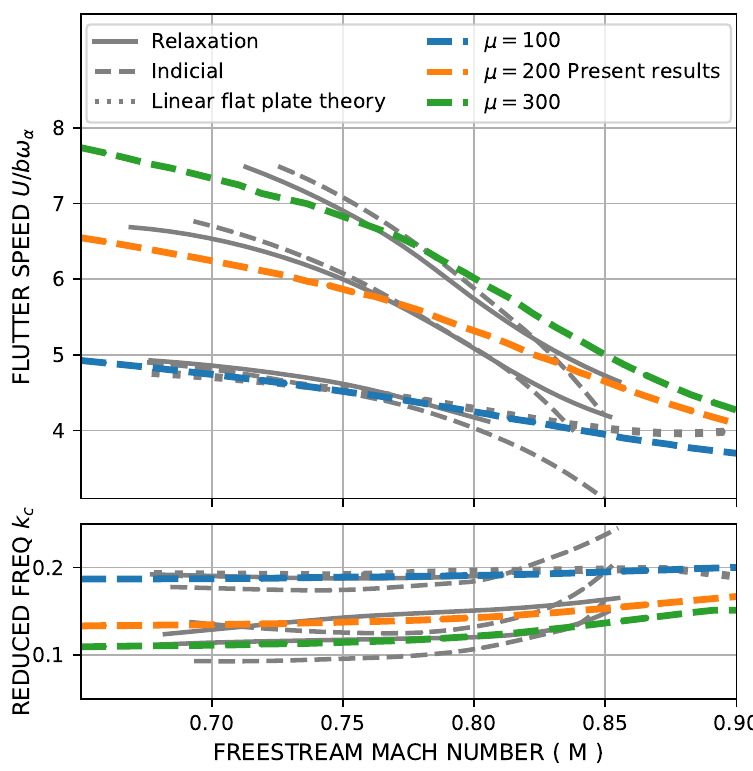
Figure 5. Flutter speed as a function of Mach number for several mass ratios